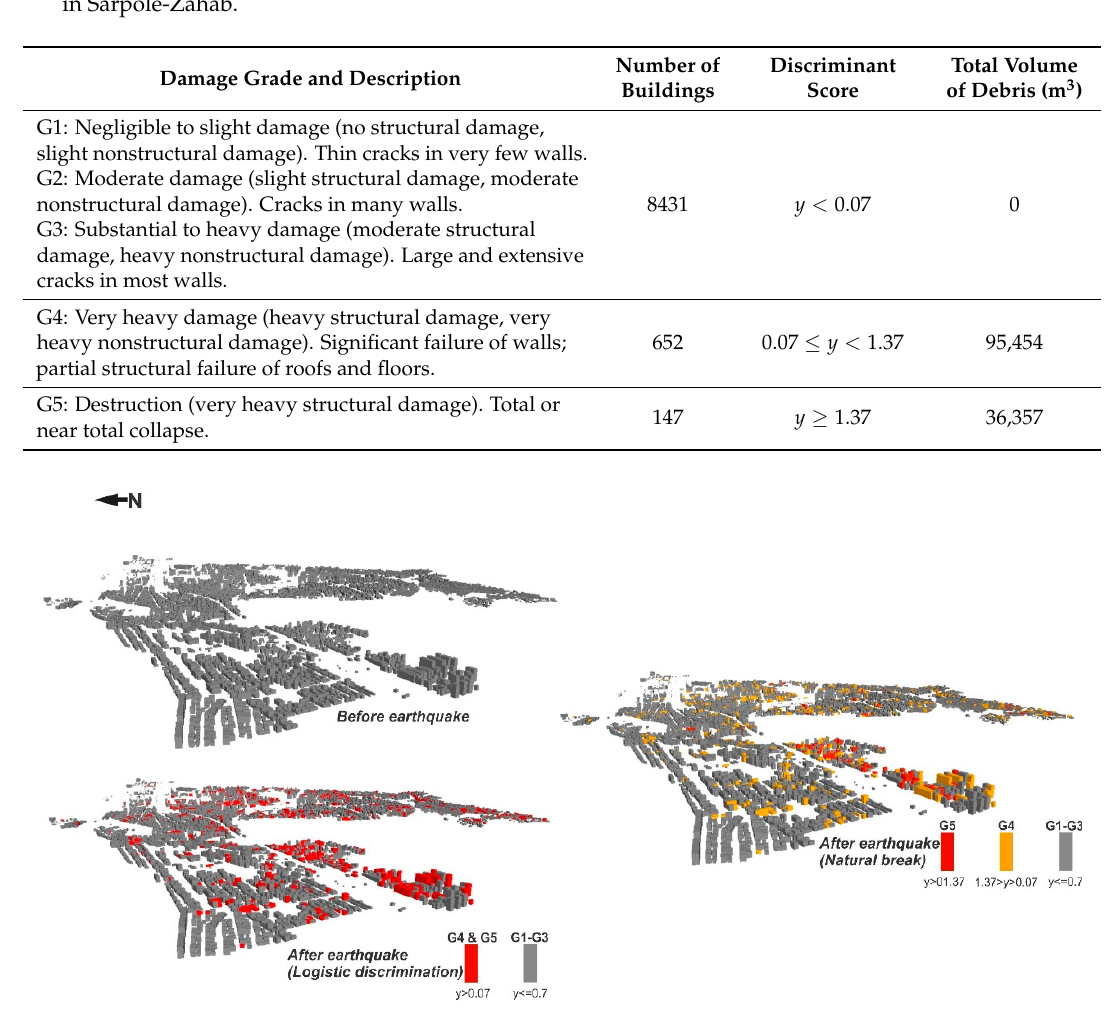
Figure 8. Three-dimensional map of Sarpole-Zahab based on the logistic discrimination and natural break optimization. The representations of the building heights are twice that of the real values.